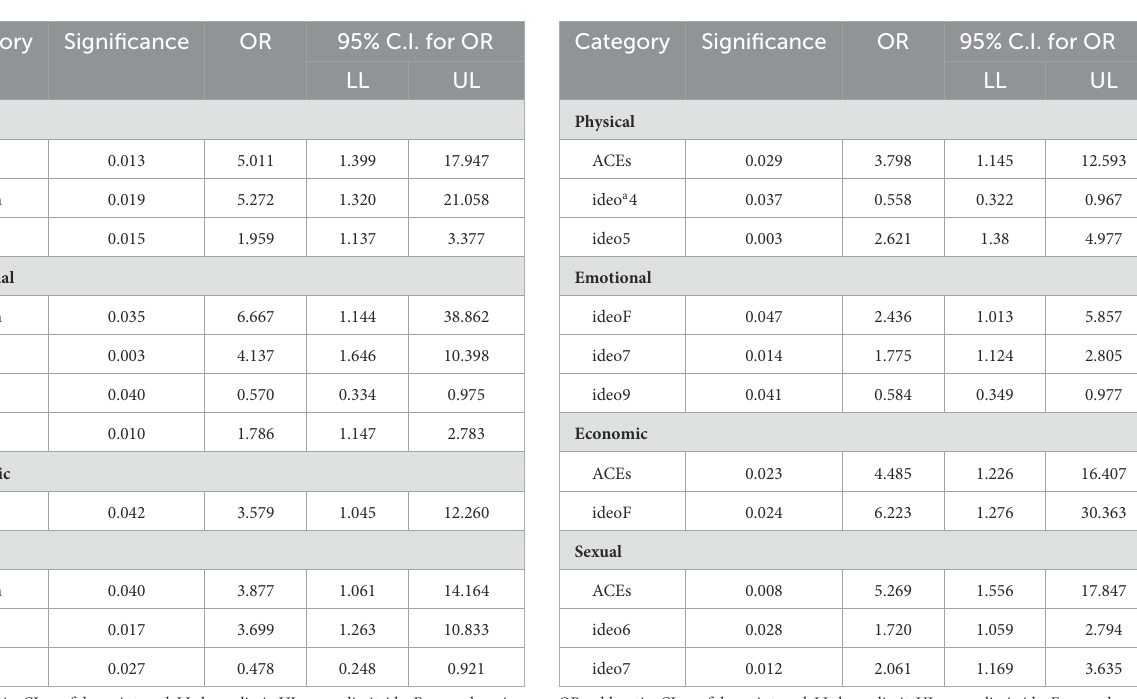
TABLE 6 Binary regression analysis result of Group 3. TABLE 7 Binary regression analysis result of Group